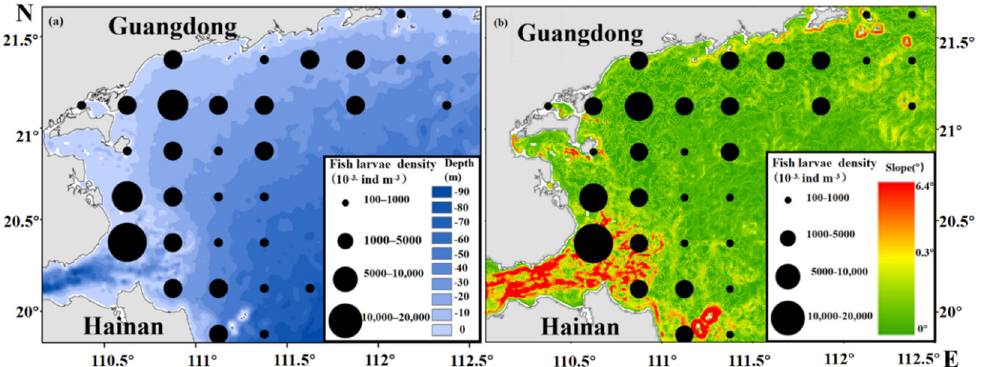
Figure 4. Relationship between the fish larvae density and spatial factors in the western Guangdong waters (WGWs): ( a ) distribution of fish larvae density and depth, ( b ) distribution of fish larvae density and slope.